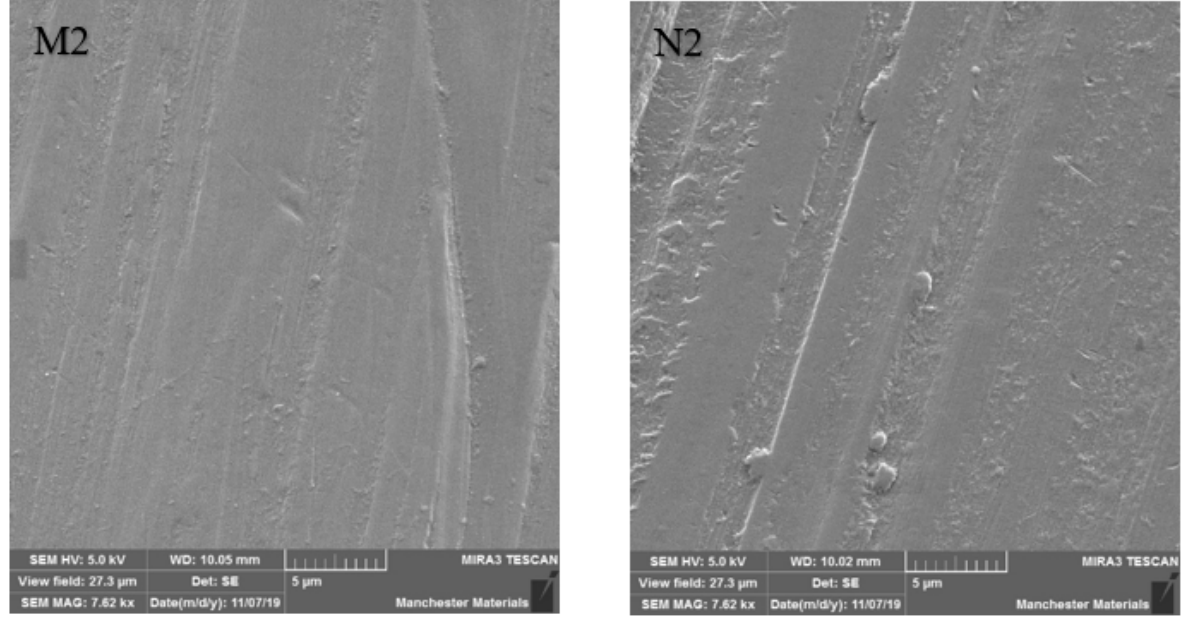
Figure 9. SEM imaging at 7.62 kx magnification at a point away from impact. Note smoother M2 surface compared to N2.